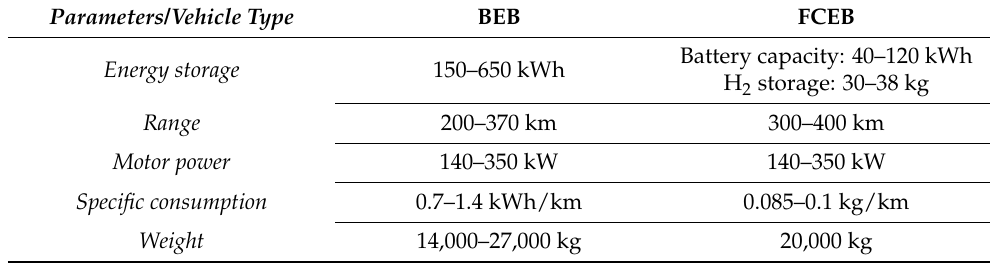
Table 2. Vehicle study